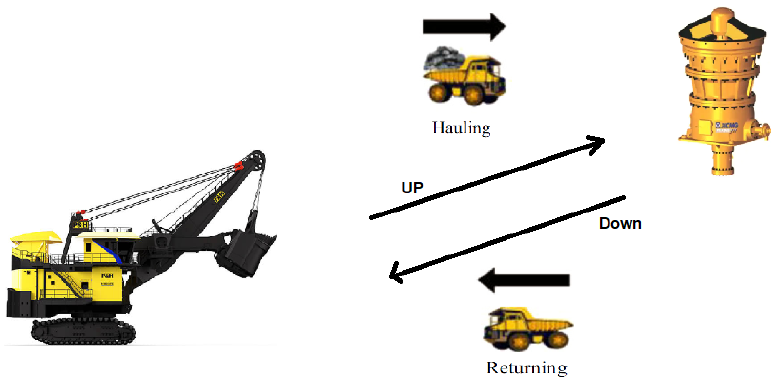
Figure 2. Truck route layout.